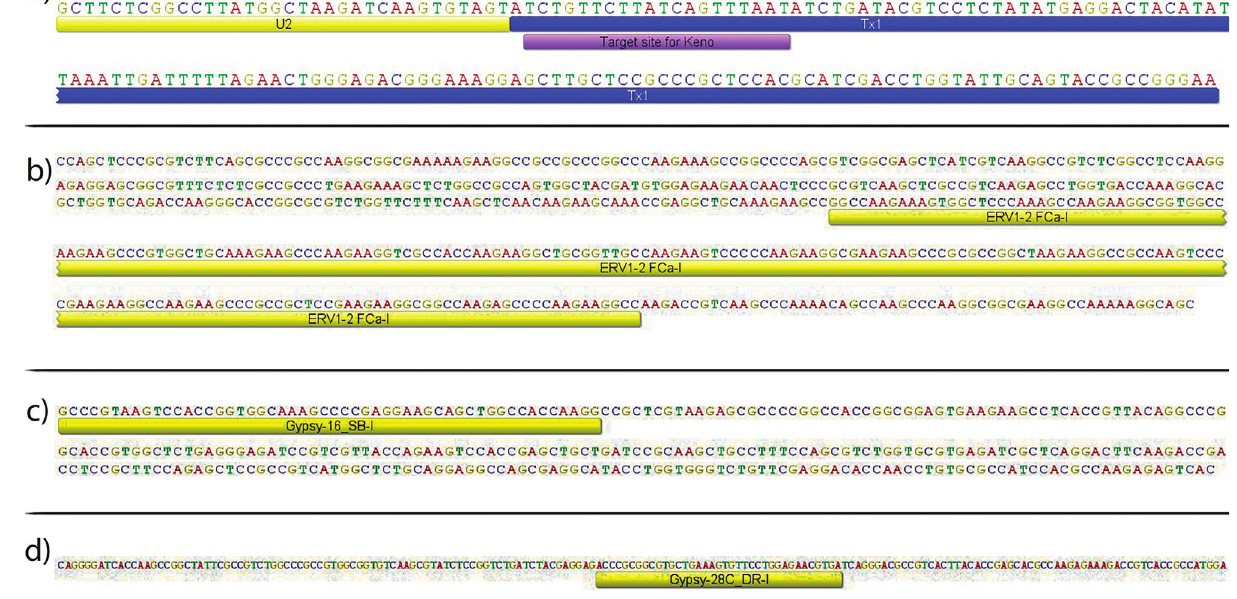
Figure 1 - Partial sequences of multigene families isolated from C. gomesi genome, with TE insertion. (a) Partial sequence of the U2 snRNA gene (yel- low), associated with its specific U2-target Keno TE (blue); histone partial sequences, with the internal portion of TEs; (b) H1 with retrotransposon ERV1 (yellow); (c) H3 with retrotransposon Gypsy (yellow); (d) H4 with retrotransposon Gypsy